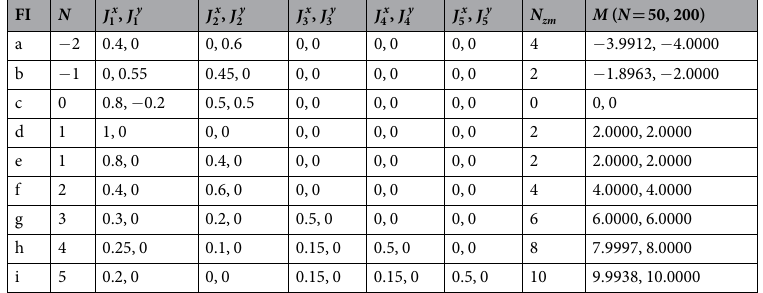
Table 1. Typical examples illustrating the relations among winding numbers, zero modes and Majorana charges. The values of J nx and J ny ( n ∈ [1, 5] ) are the parameters for equations of plots in Fig. 1 with figure index (FI) (a)–(i) and corresponding numbers  . For finite size systems with N = 50 and 200, the zero modes and Majorana charges are obtained by exact diagonalizations. We define the zero modes by selecting eigenstates with absolute eigenvalues less than 10 − 3 . N zm is the number of such eigenstates for every cases. The Majorana charges are calculated from Eq. (55) for given zero mode states. We can see that  = N 2